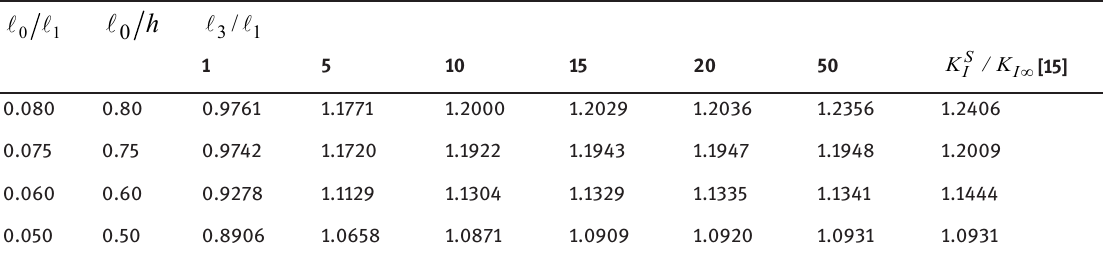
Table 1: The values of SIF at 1 / 0 s =  obtained for various values of the ratio isotropic.